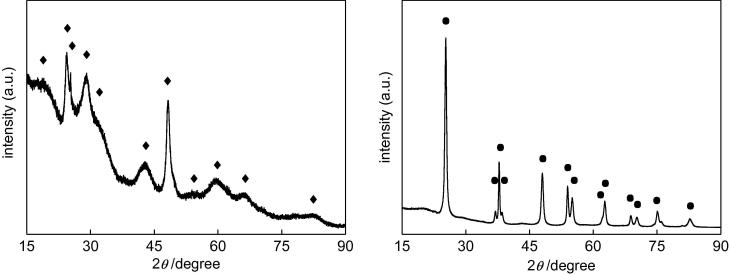
XRD patterns of (left) TNWs and (right) OAPs: ♦ – K2Ti8O17, ● – anatase titania.